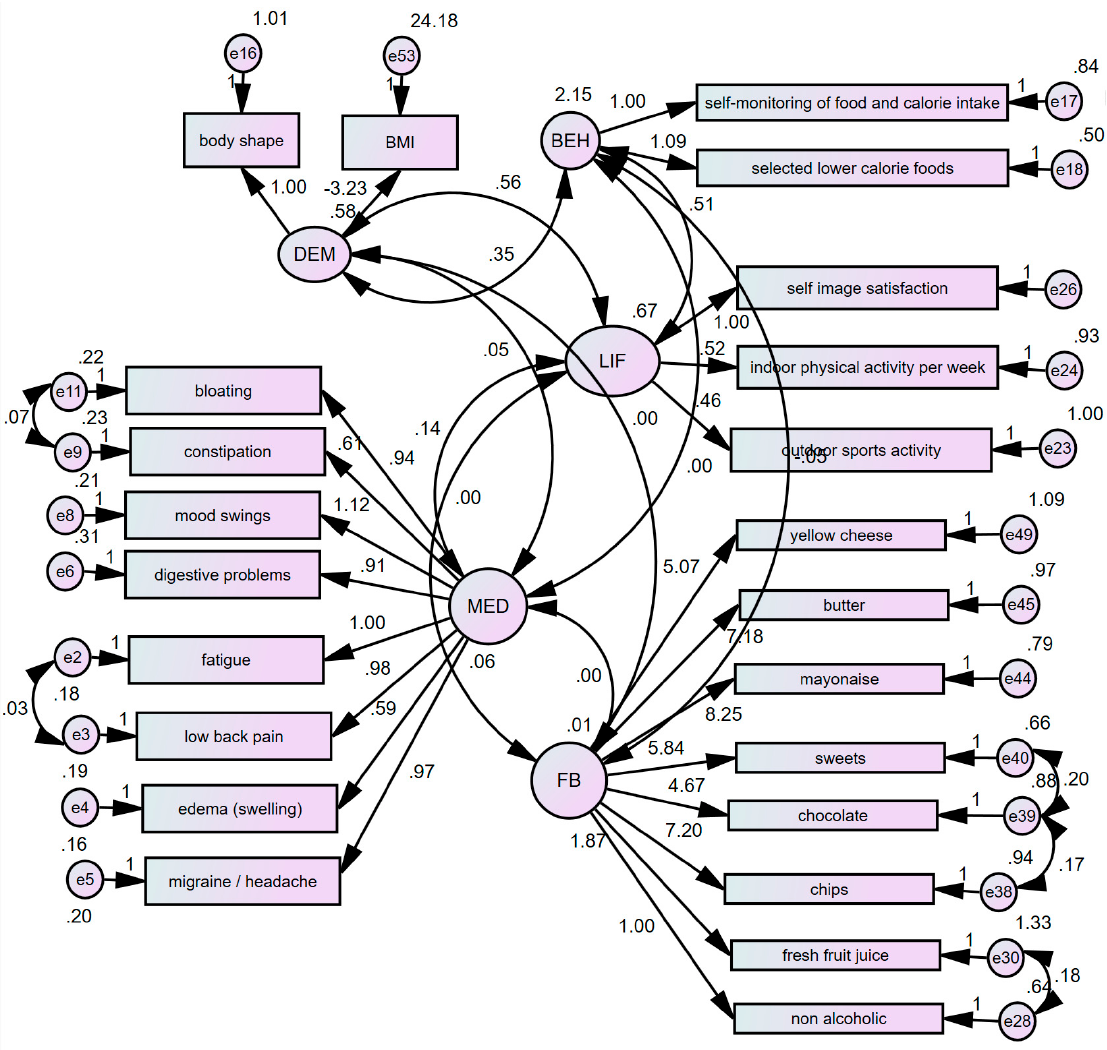
Figure 2. Modified Structural Equation Model. (N = 514. chi-square = 399.330; degrees of freedom df = 215; p < 0.001; e = error).